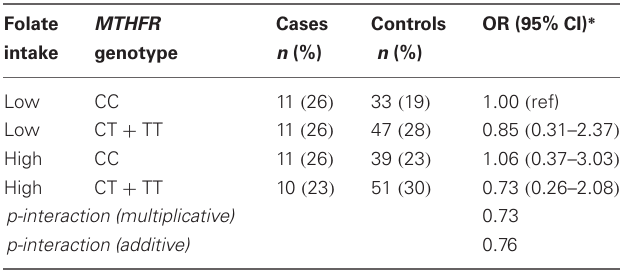
Table 4 | Folate intake, MTHFR C677T genotype, and prostate cancer risk (43 cases, 170 controls).